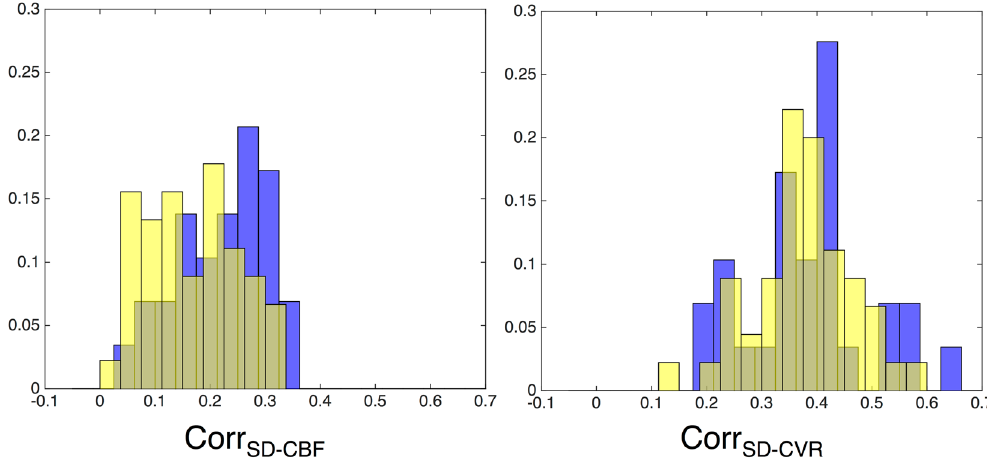
Figure 3. Histograms of within-subject voxel-wise correlations of SD BOLD -CBF and SD BOLD -CVR relations for younger (blue) and older (yellow) adults. Note: Y-axis values represent normalized histogram proportions due to different sample sizes in each age group (young adults, n = 29; older adults n =